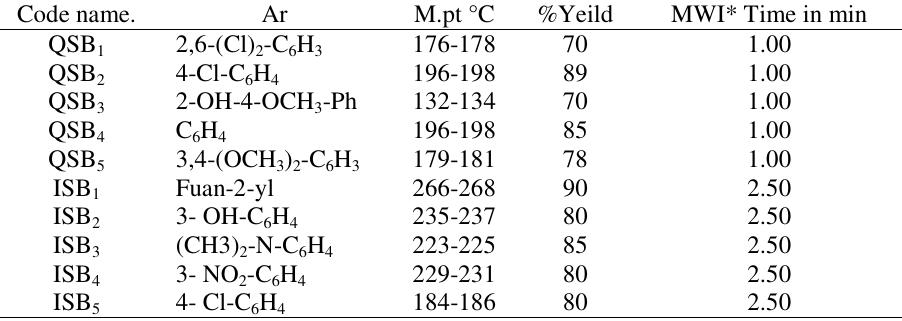
Table 2. Physical constants of the compounds and